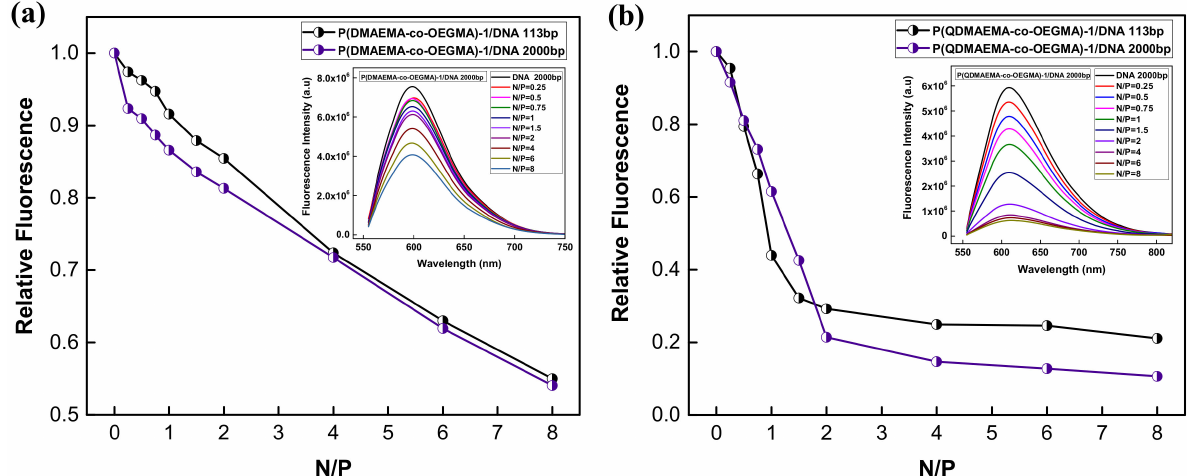
Figure 5. Ethidium bromide fluorescence quenching in ( a ) P(DMAEMA-co-OEGMA)-1/DNA of 113 bp and 2000 bp and ( b ) P(QDMAEMA-co-OEGMA)-1/DNA of 113 bp and 2000 bp polyplexes. Indicative fluorescence spectra of the intercalated ethidium bromide for polyplexes with DNA of 2000 bp are also included in Figure